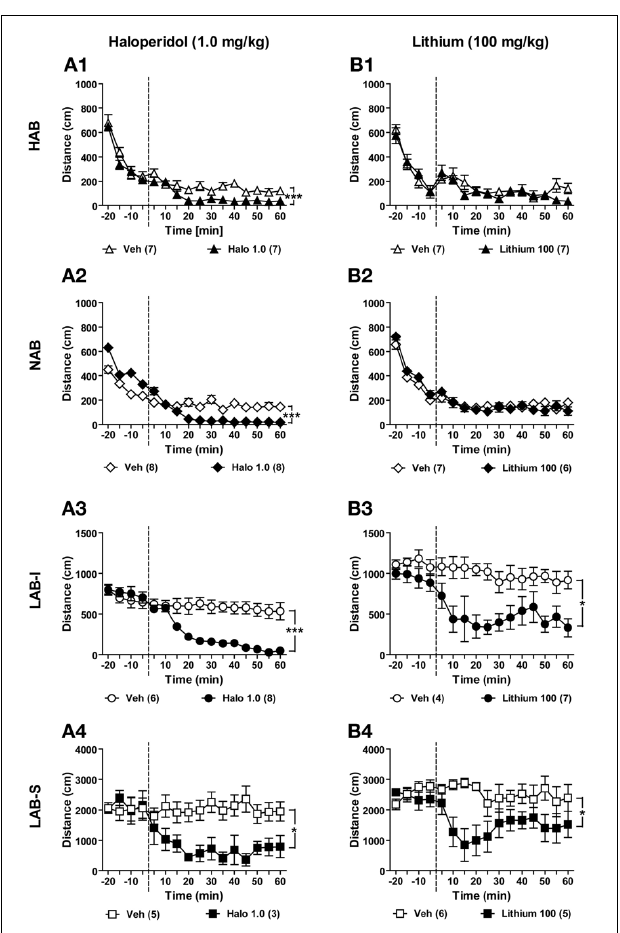
FIGURE 12 | Haloperidol and lithium suppressed locomotor activity in LAB mice. Mice of all four lines were used for testifying the effects of haloperidol and lithium. (A1–A4) After 20min of baseline exposure to the OF, HAB, NAB, LAB-I, and LAB-S mice were treated with either saline (Veh) or haloperidol (Halo) at 0min (dashed lines). Treatment with haloperidol (1.0mg/kg) significantly reduced locomotion in all mice. (B1–B4) New batches of mice were treated with either saline (Veh) or lithium (Lithium) at 0min (dashed lines), and distance traveled was continuously measured for 60min. Lithium (1.0mg/kg) specifically decreased locomotion in LAB-I and LAB-S mice, but did not induce any change of locomotion in HAB and NAB mice. Mean ± SEM. ∗∗∗ p < 0 . 001; ∗ p < 0 . 05 compared with Veh (ANOVA